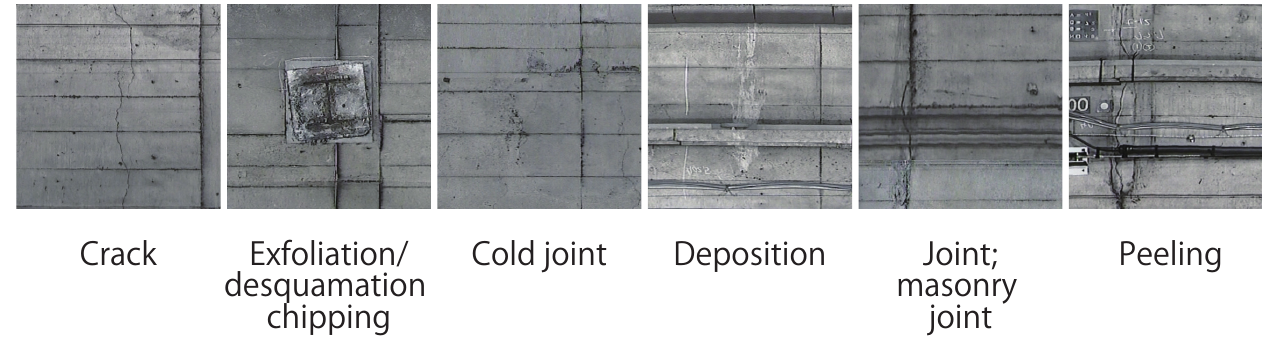
Figure 3. Examples of distresses in the dataset.